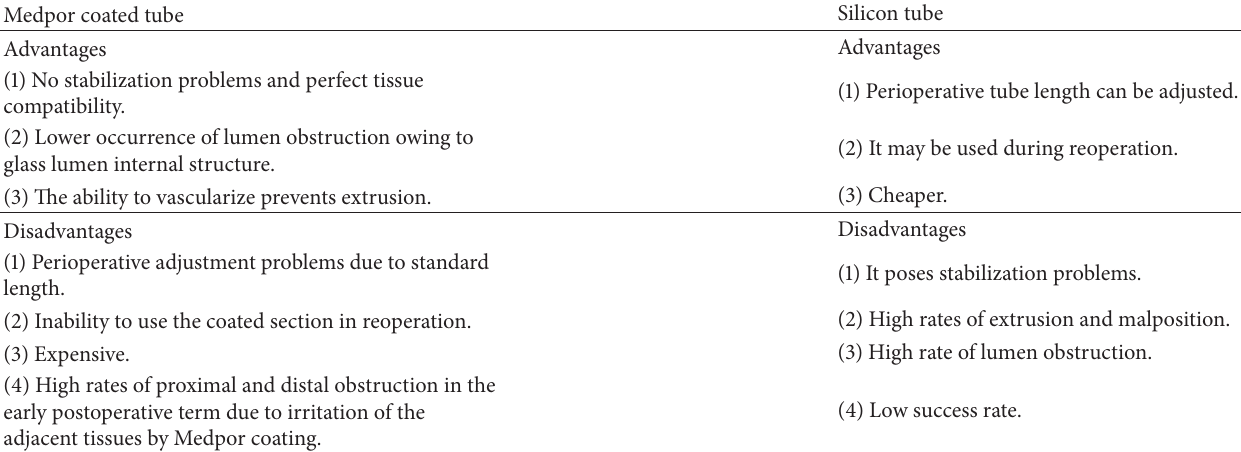
Table 3: The comparative advantages and disadvantages of both